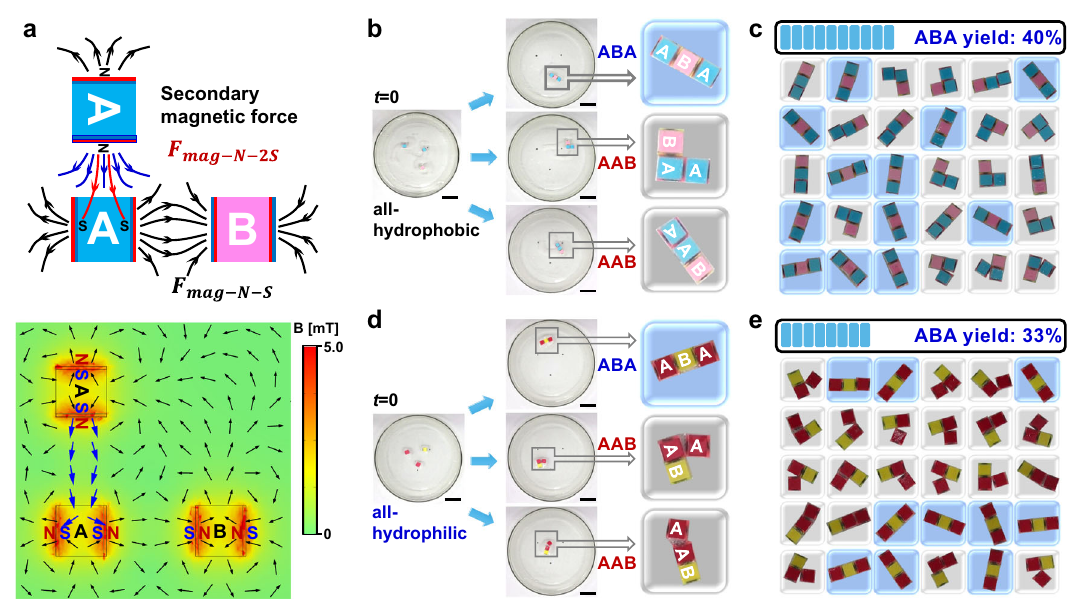
Fig. 5 | Control experiments of MSA with isomers when lacking of local capil- laryself-alignments.a SchematicalillustrationofAABclustersformedbytheweak secondarymagneticforce( F mag (cid:3) N (cid:3) 2 S )besidesthestrongopposingmagneticforce of F mag (cid:3) N (cid:3) S and the bottom is the simulated distribution of local magnetic fi eld.